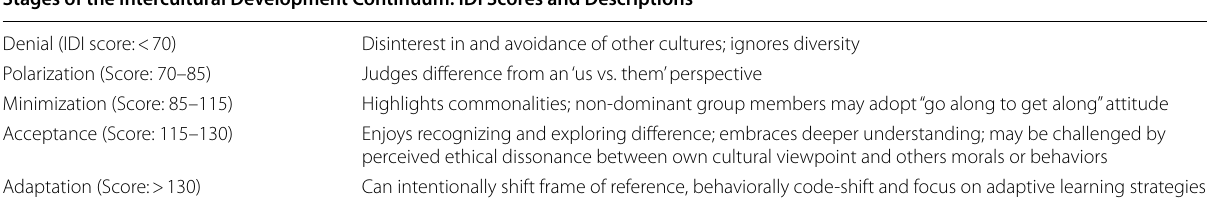
Table 2 Intercultural development stages (IDI, LLC; 2017) Stages of the Intercultural Development Continuum: IDI Scores and Descriptions Denial (IDI score: < 70) Disinterest in and avoidance of other cultures; ignores diversity Polarization (Score: